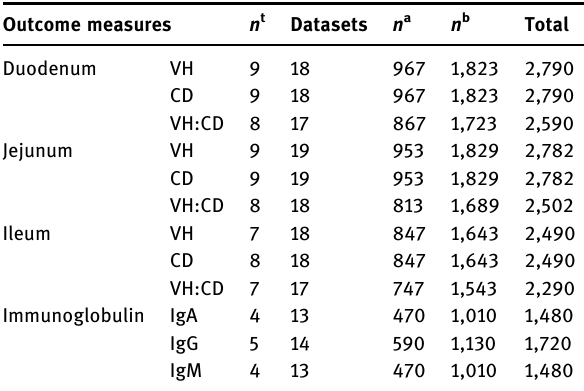
Table 2: Datasets and number of broiler chickens included in the meta - analysis Outcome